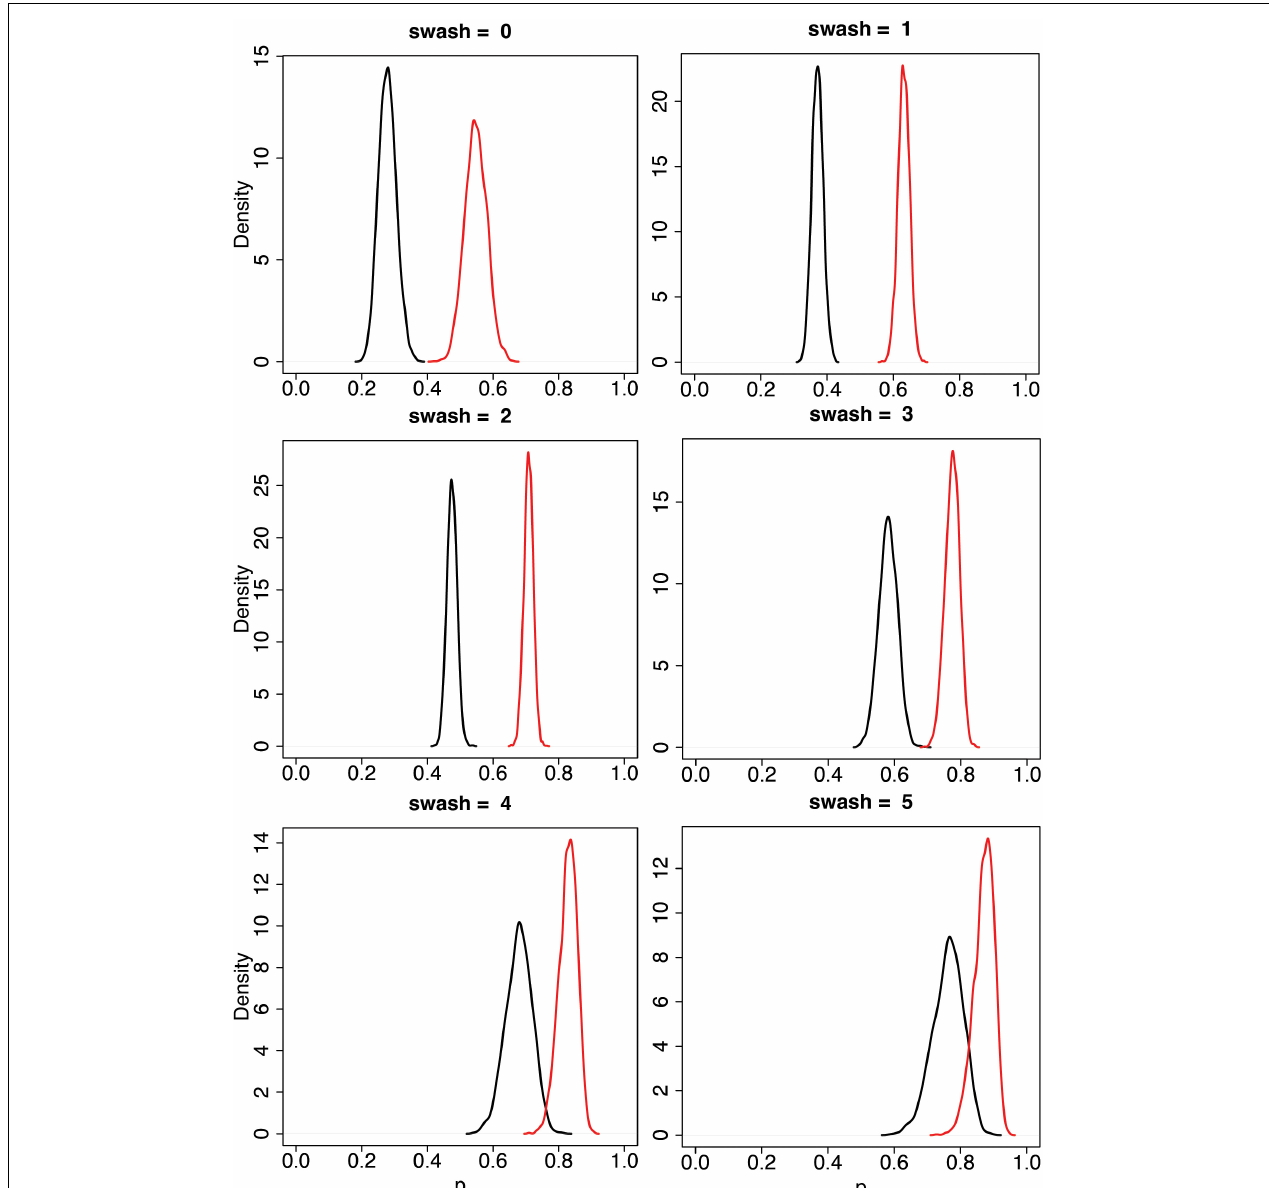
FIGURE 5 | Posterior distributions of the mean for pss and pas by values of swash = 0 , 1 ,.., 5. The black curves are for pas and the red curves for pss . These are from the Bayesian model (Eqs 2, 3). The horizontal axis ( p ) represents pss or pas , and the vertical axis is the probability density, so that areas under the curve are probabilities. The posterior distributions are updates from the prior distributions based on the data. As can be seen the posterior distributions are clearly different for the synchronous (red) and the asynchronous conditions (black) for all levels of trait hypnotisability (SWASH) including the extrapolated high SWASH scores 4 and 5.